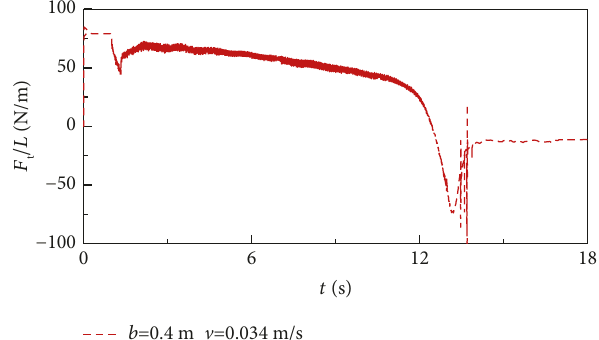
Figure 14: Total hydrodynamic load evolution during the water-exit